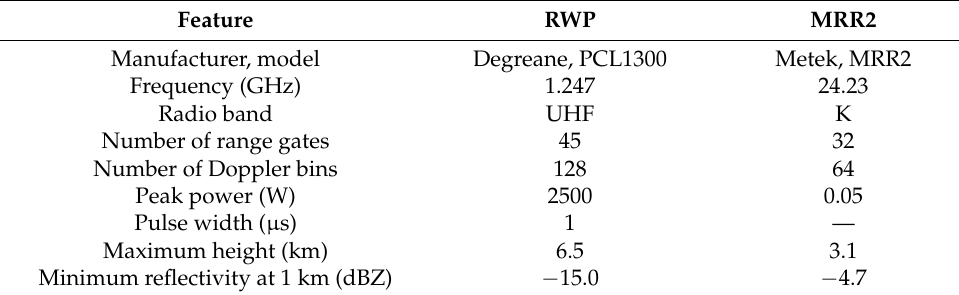
Figure 1. Topography of the Eastern Pyrenees region of study showing the location of the aerodrome (A) with most of the instrumentation: Micro Rain Radar (MRR2), Disdrometer and AWS from the Meteorological Service of Catalonia. Location of an additional M é t é o-France AWS (number S8) and the Ultra-High Frequency wind profiler (UHF RWP). The main mountain peaks of Carlit (2921 m ASL), Puigpedr ó s (2914 m ASL) and Puigmal (2913 m ASL) are also labelled, as well as Andorra, France and Spain and their borders. Table 2. Main features of the RWP and MRR2 used in this study.